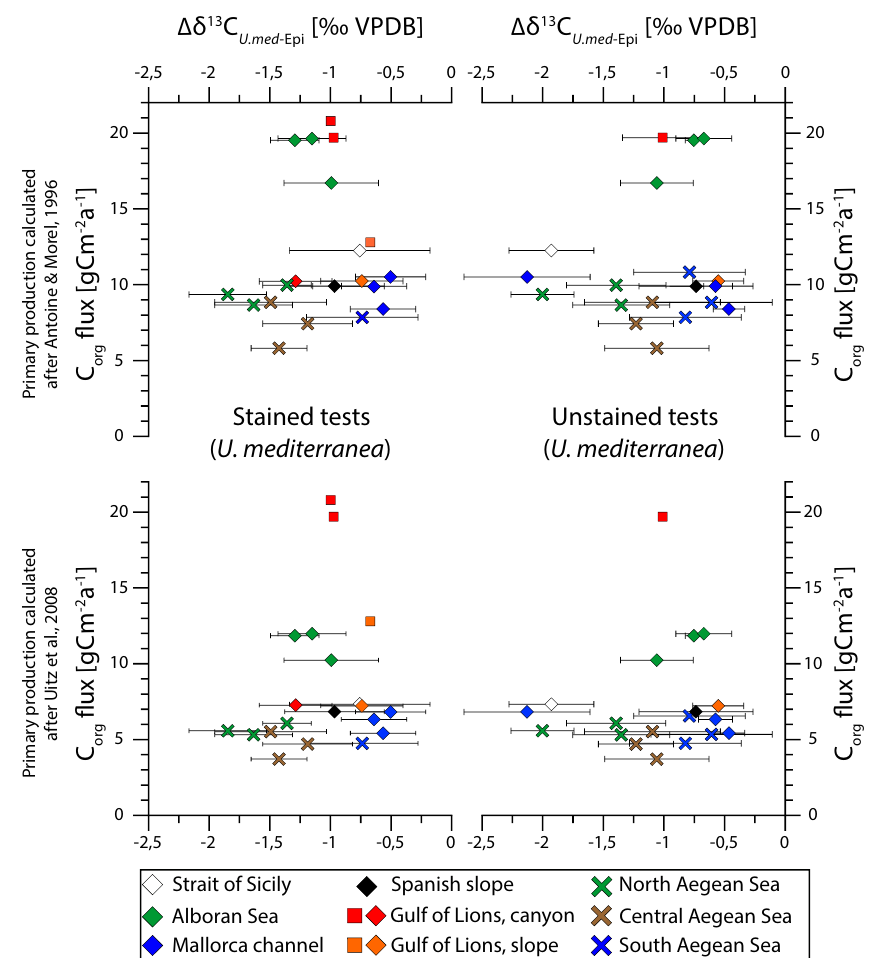
Figure 5. The δ 13 C difference between live and dead Uvigerina mediterranea and epifaunal taxa ( (cid:49)δ 13 C Umed-Epi ) against organic carbon flux rates (C org flux) calculated from primary productivity in surface waters after Betzer et al. (1984). As in Fig. 4, satellite-derived primary production values of Antoine and Morel (1996) (top) and Uitz et al. (2008) (bottom) were